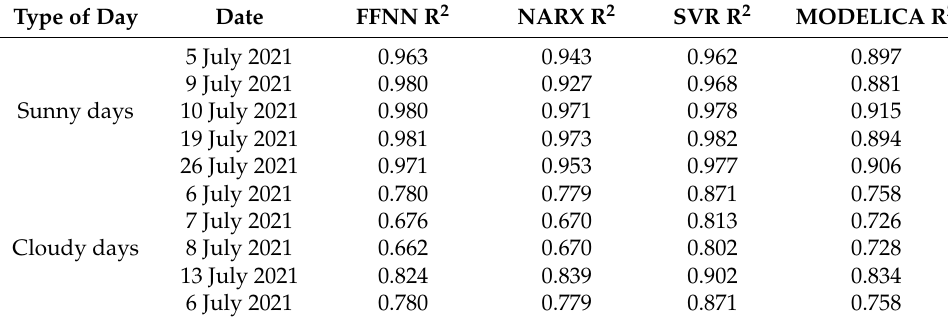
Figure 14. Forecast of PV generation for a week of July with OpenModelica model. Table 7. Results of the four models for five sunny days and five cloudy